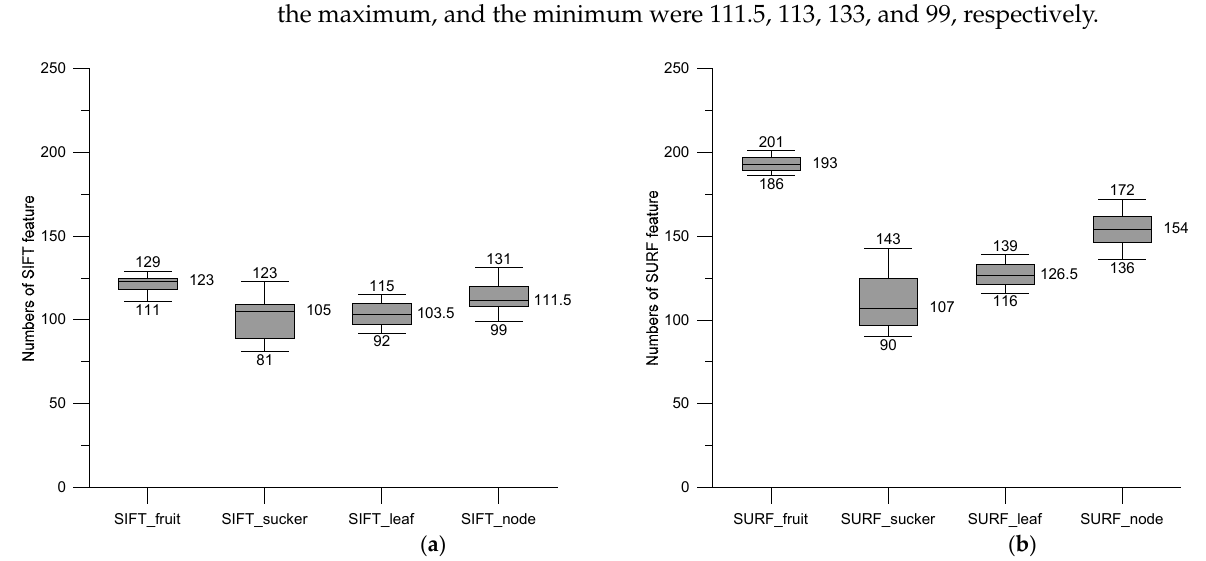
Figure 14. Numbers of SIFT features ( a ) and SURF features ( b ).